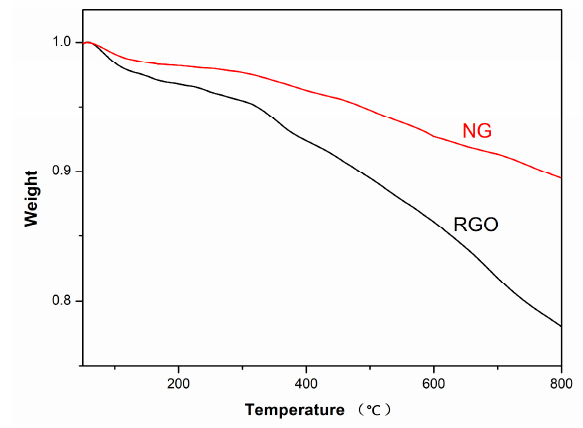
Figure 3. TGA curves of the RGO and NG fillers.